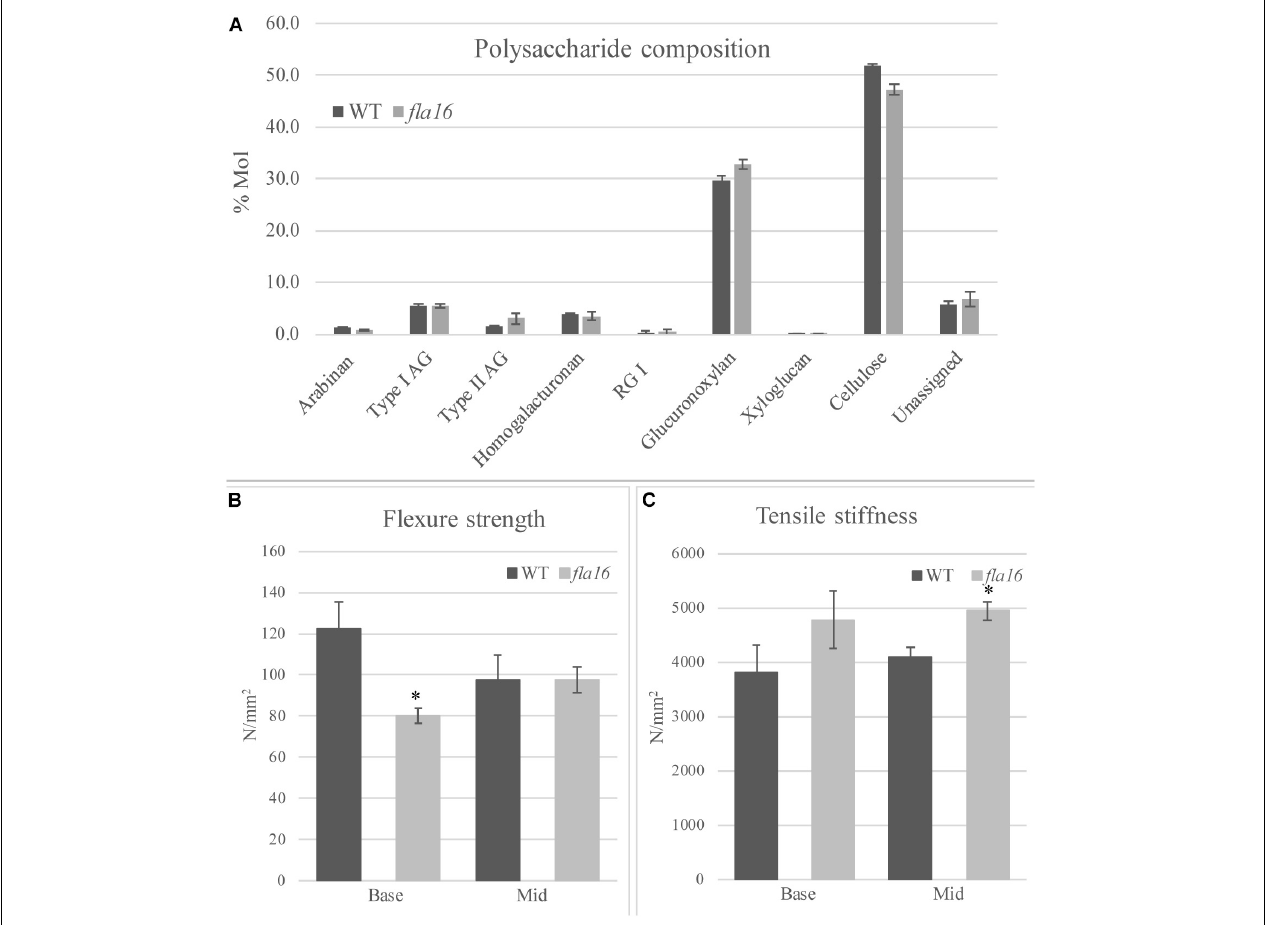
FIGURE 4 | Cell wall polysaccharide composition derived from linkage analysis and biomechanical tests of mature stems of fla16 and WT. (A) Polysaccharide linkage analysis shows a reduction of cellulose and an increase in glucuronoxylan in fla16 compared to WT with no difference in the other polysaccharides. N = 2–3 biological replicates. For full data see Supplementary Table S3 . Biomechanical tests on the base- and mid- stem show significantly decreased flexure strength (B) in the base stem of fla16 compared to WT and increases in tensile stiffness (C) . N = 6–12 stems, p < 0.05 ( ∗ ) using a Student’s t test. Data are presented as means ±